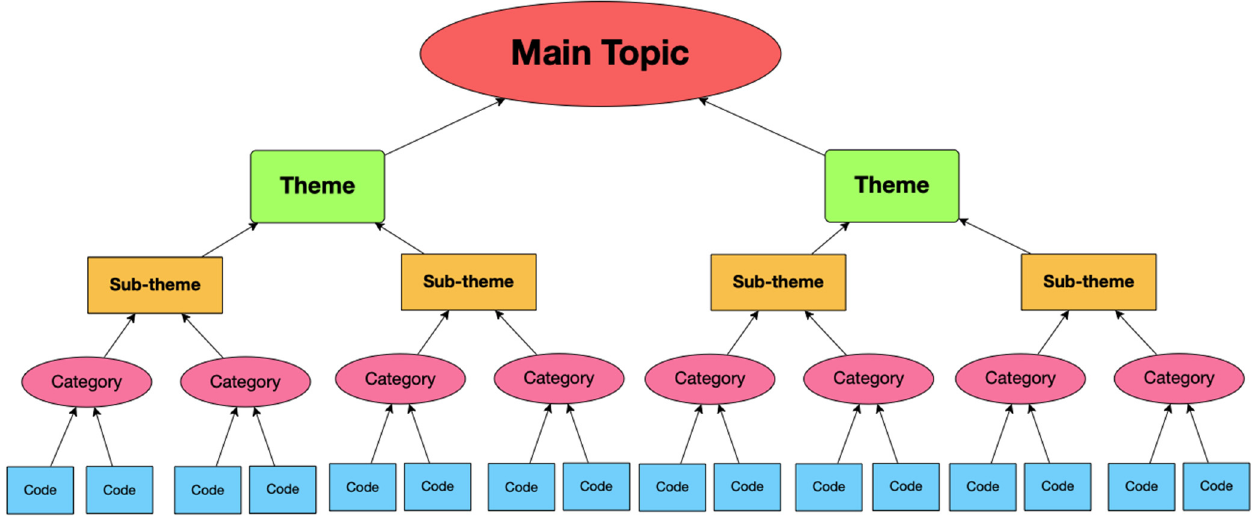
Figure 3. An illustration of the conceptual map.